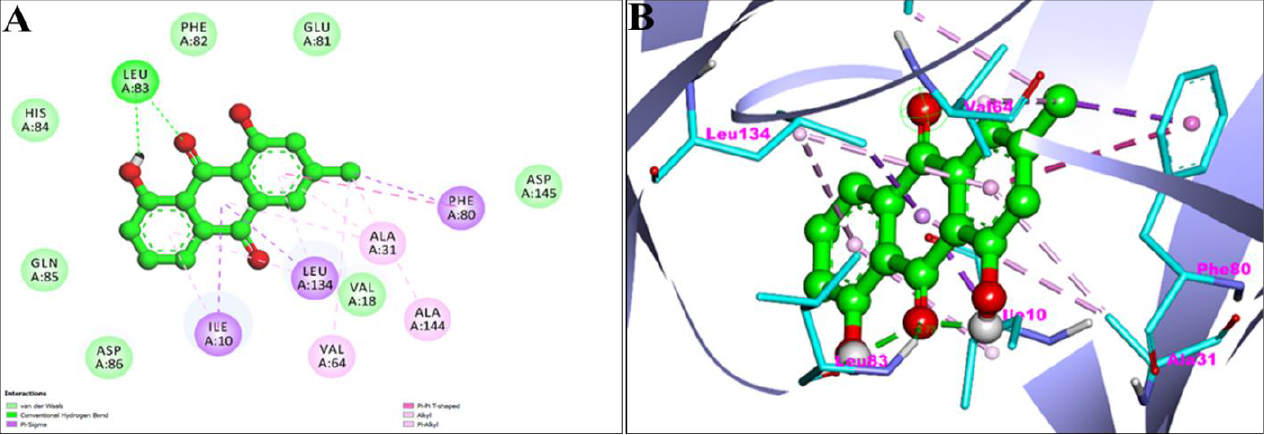
Figure 10. 2D ( A ) and 3D ( B ) representation of interaction of chrysophanol (green color) and cyclin- dependent kinase 2 (purple color with ribbon pattern) (PDB:6GUE).